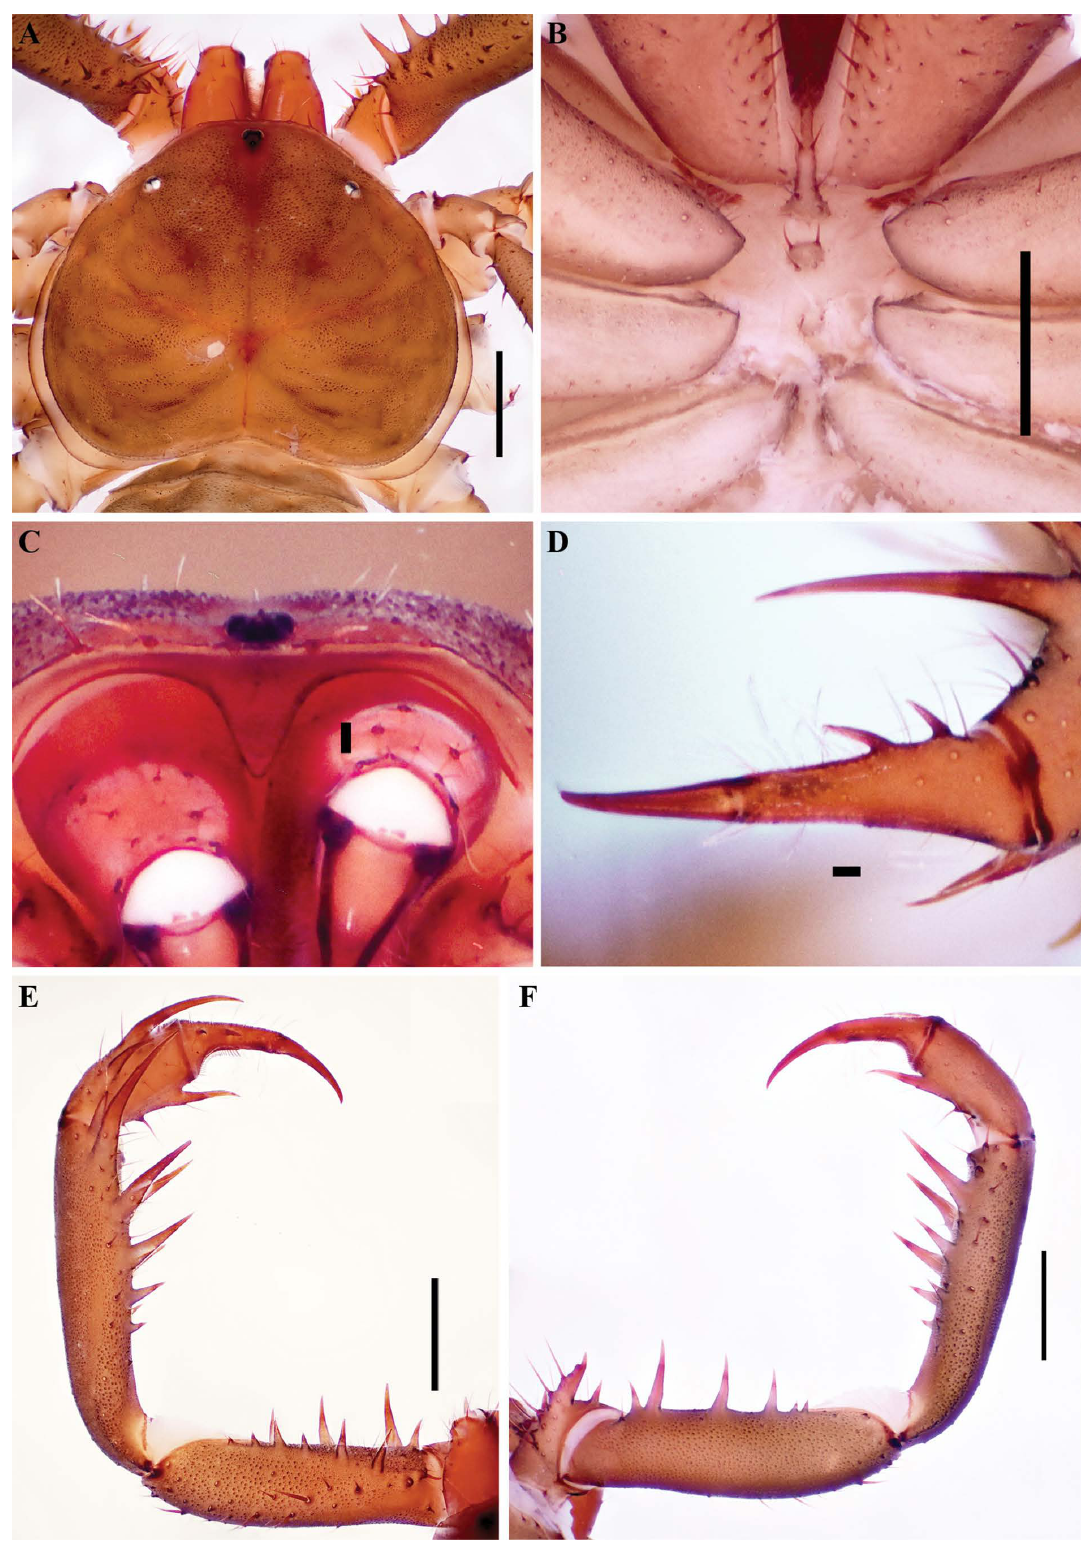
Fig. 54. Charinus cearensis sp. nov. (CHNUFPI 1255), general morphology, ♀. A . Carapace, dorsal view. B . Sternum, ventral view. C . Frontal process. D . Pedipalp tarsus, frontal view. E . Pedipalp, dorsal view. F . Pedipalp, ventral view. Scale bars: A–B = 0.5 mm; C–D = 0.1 mm; E–F = 1